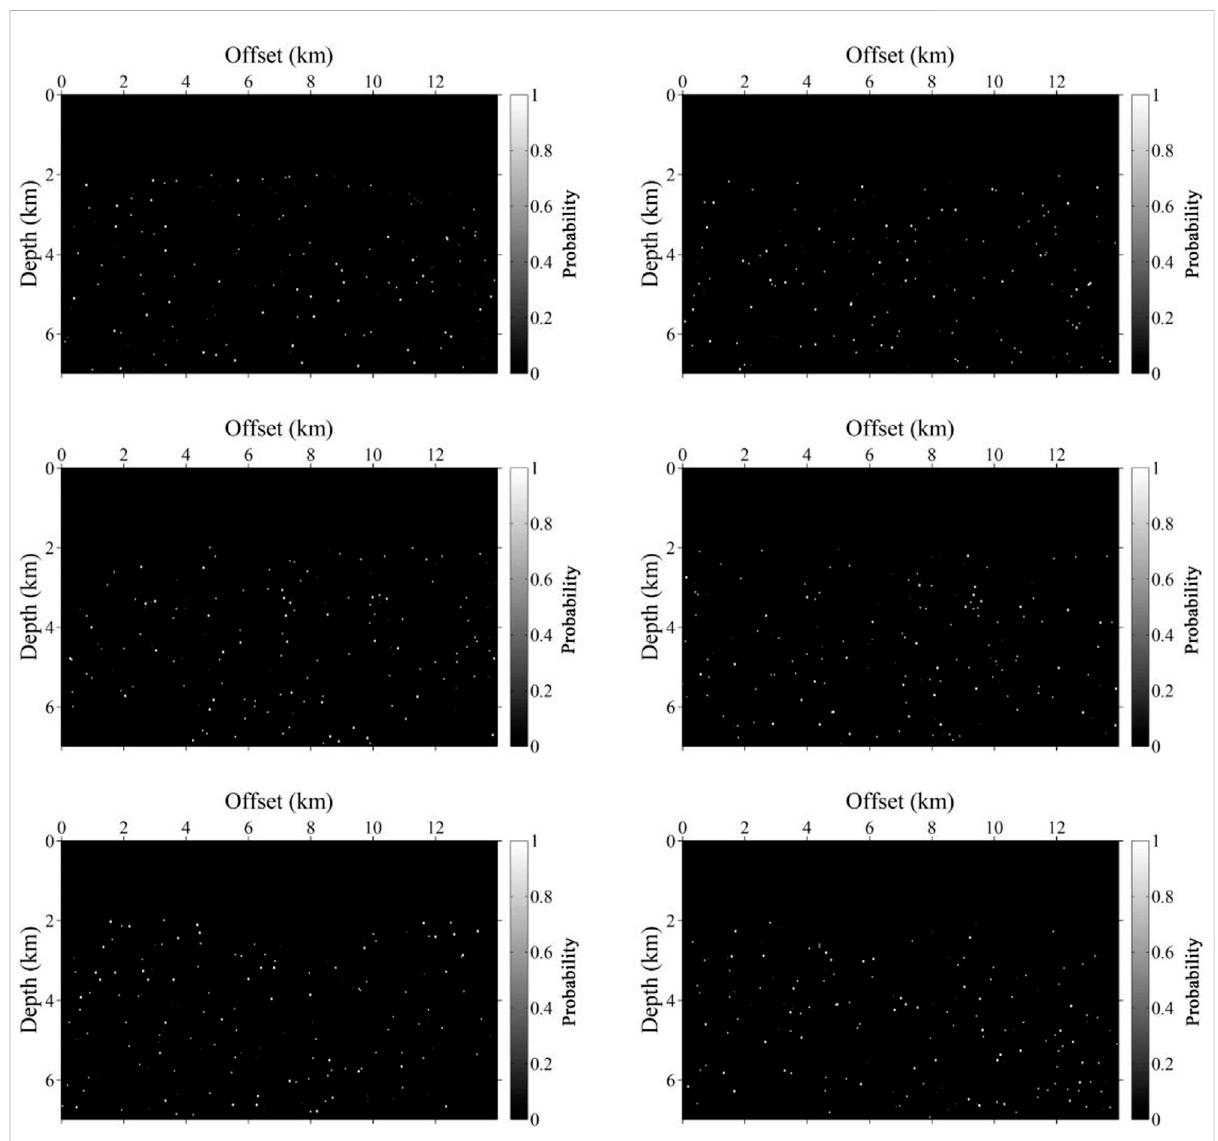
FIGURE 3 Sixlabels correspond to thevelocity models with karst caves inFigure2. The white spots in thebinary images denote karst caves (ones) and the elsewhere black area represents non-karst caves